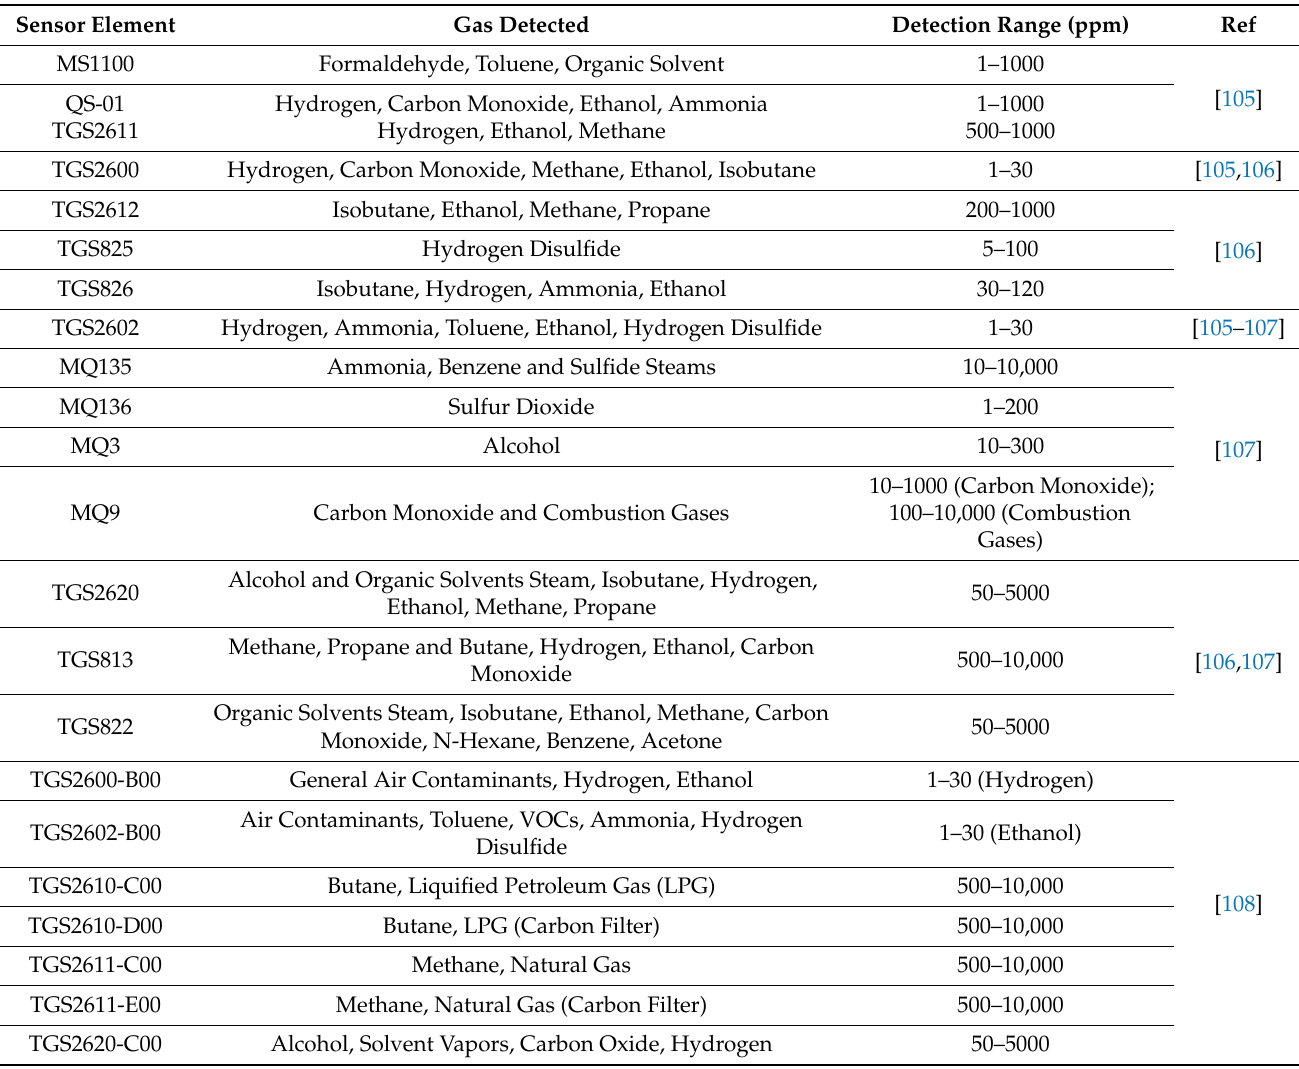
Table 2. VOCs and gaseous contaminants present in the